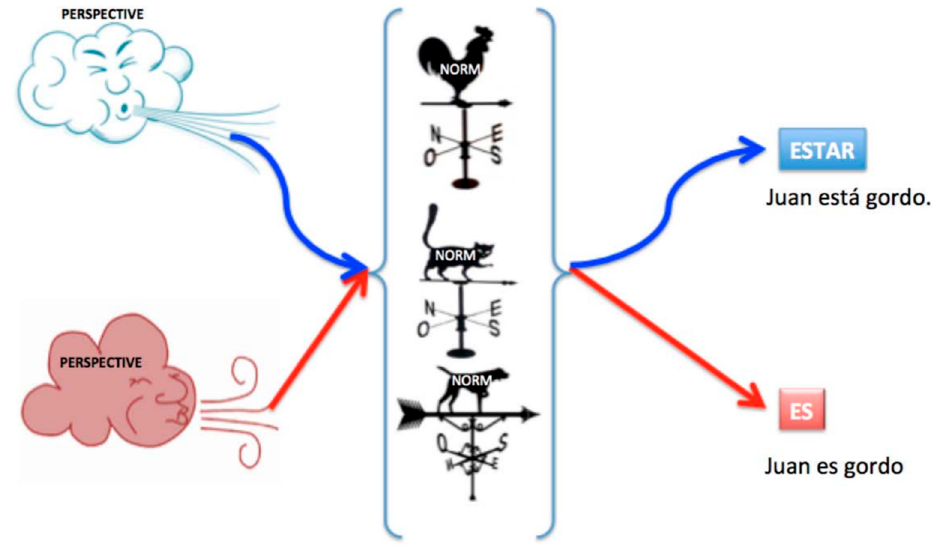
Figure 1. Slide containing the wind vane model used by Negueruela and Fernández Parera (2016).